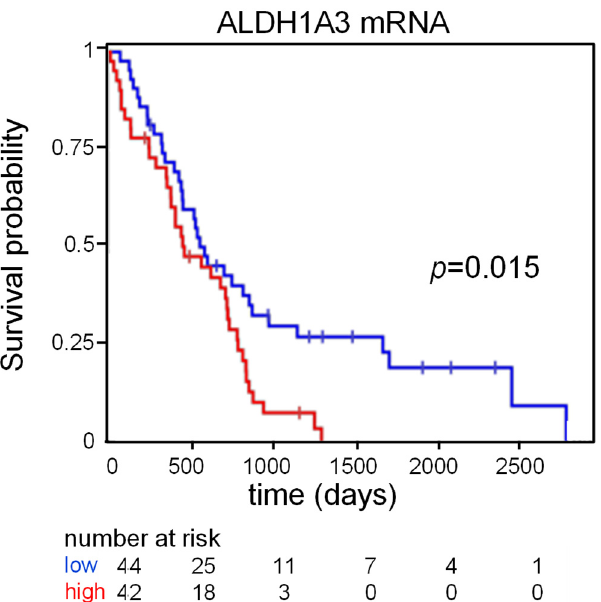
Figure 1. Expression of ALDH1A3 holds prognostic significance in MPM: Kaplan–Meier plot from TGCA samples ( n = 84) showing stratification of MPM patients based on ALDH1A3 mRNA levels. Overall survival (days) is shown on the X-axis. p -value is reported.